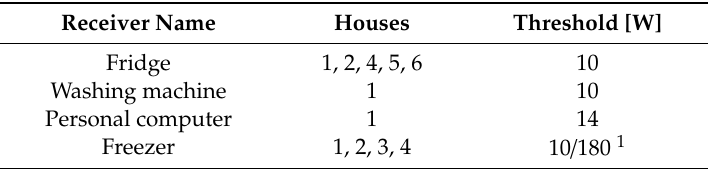
Table 2. Four modelled receiver